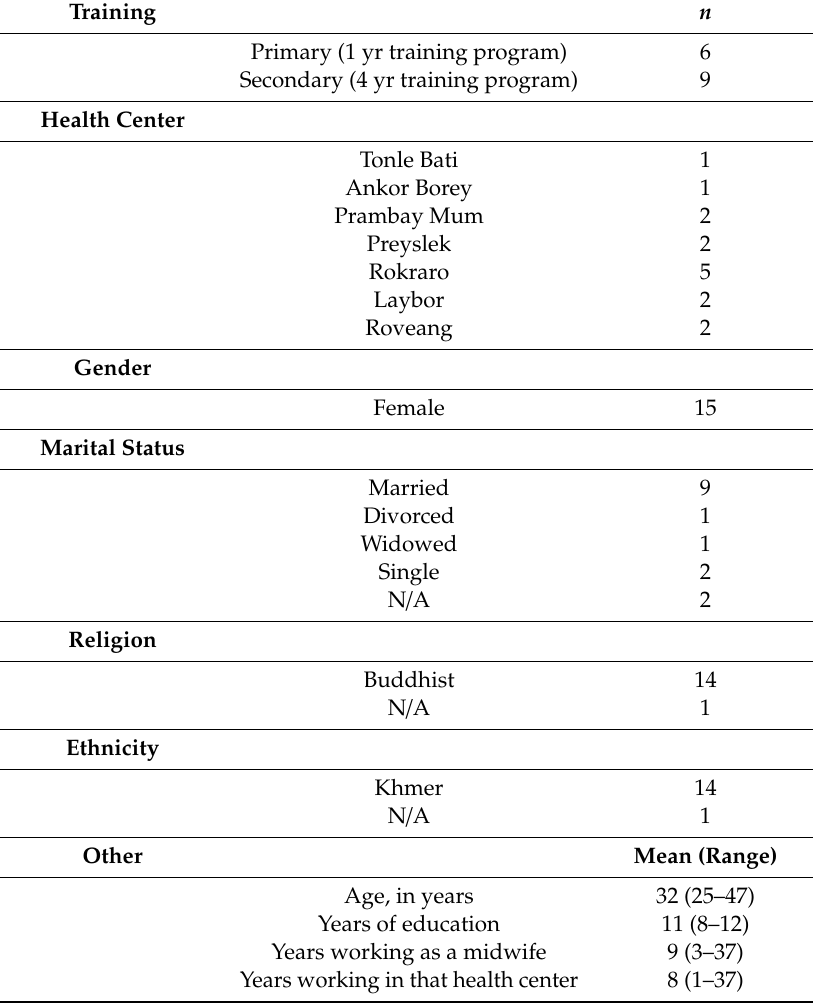
Table 2. Characteristics of focus group discussion (FGD) participants: midwives (N =